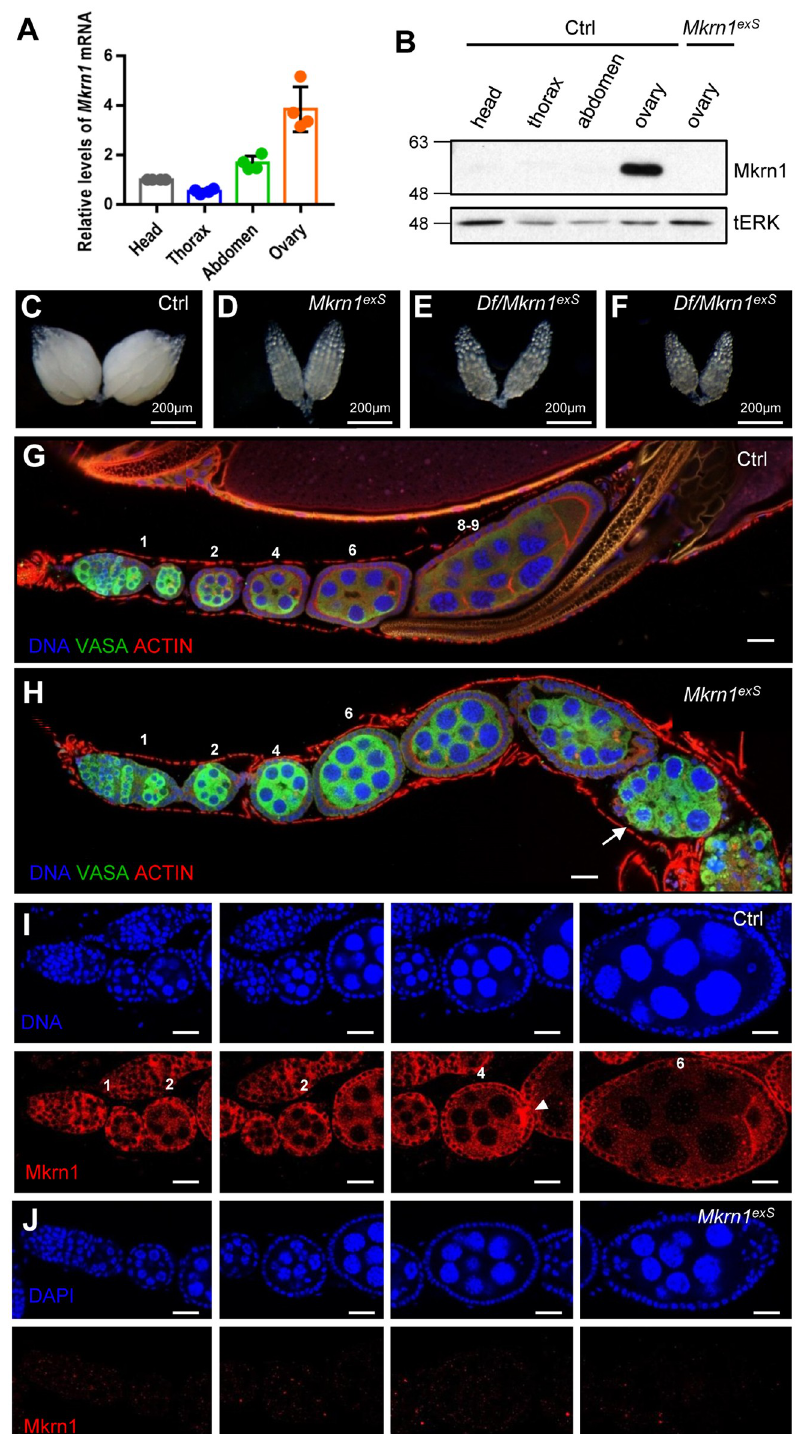
Fig 1. Mkrn1 expression was highly enriched in control ovaries and Mkrn1 -null ovaries exhibited a phenotype. (A) One-day-old, control female flies from standard nutrient conditions were dissected for baseline analyses. Total mRNA was extracted from the heads, thoraxes, abdomens, and ovaries and analyzed by quantitative real-time PCR. Relative mRNA levels for Mkrn1 and reference gene Actin are shown. Error bars represent the SEM from four independent experiments. (B) Protein extracts from indicated tissues were analyzed by immunoblot using the anti-Mkrn1 antibody